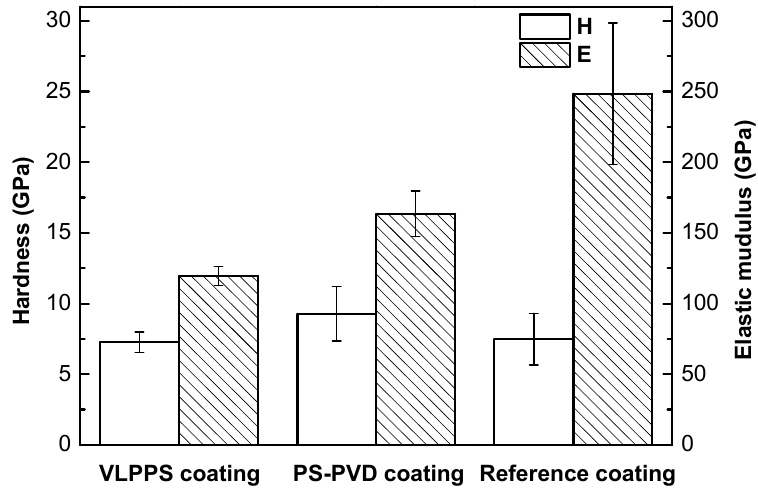
Figure 5. The mechanical properties of the as-sprayed GDC coatings and the reference GDC coating.